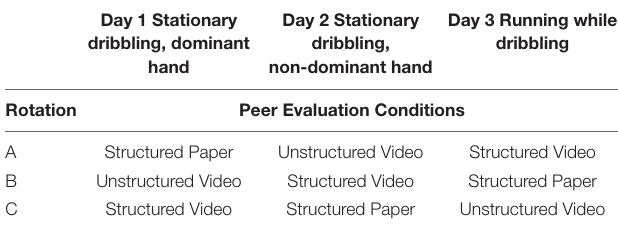
TABLE 2 | Rotations of peer evaluation